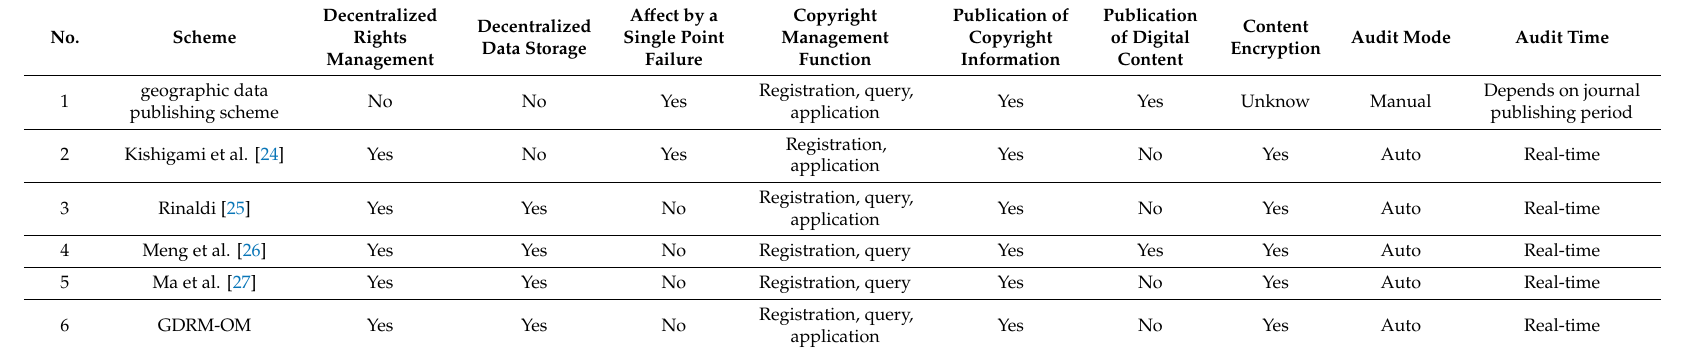
Table 8. GDRM-OM scheme comparison with traditional geographic data publishing scheme and related work